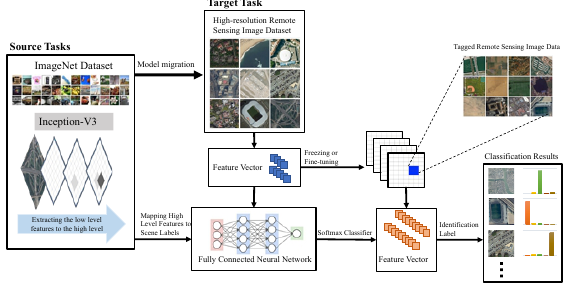
Figure 8. Flow chart of Scene Classification for High- Resolution Remote Sensing